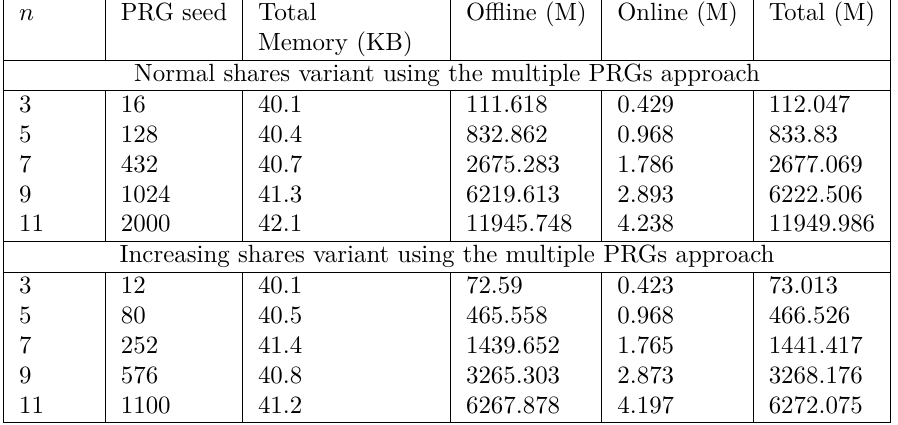
Table 6: Higher-order masked S-box computation using our variant of the table-based scheme with full pre-processing (Algorithm 4) using the multiple PRGs technique for the normal shares (Algorithm 6) and the increasing shares variants (Algorithm 8). The true random PRG seed and the total memory required for AES-128 are given in bytes and KB, respectively. The offline, online and total execution are represented in millions of clock cycles.